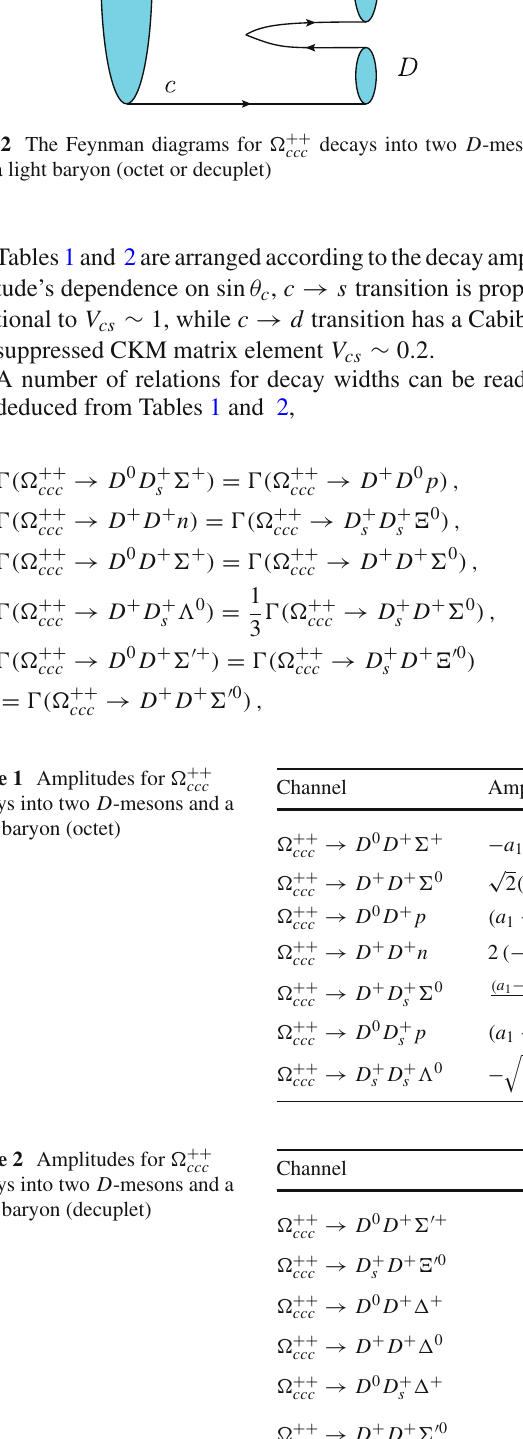
Table 2 Amplitudes for (cid:2) ++ ccc decays into two D -mesons and a light baryon (decuplet)